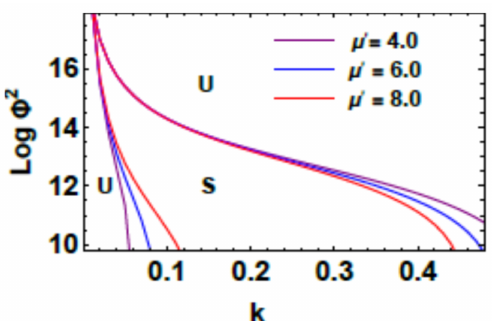
Figure 19. Variation of Log Φ 2 with k to depict the contribution of Equations (53) and (54) along with data A for different values the parameter µ (cid:48) .